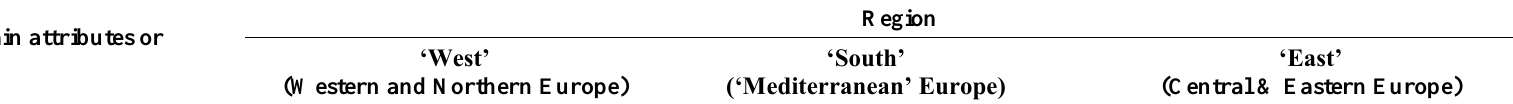
Table 1. Main phases of European migration and their characteristics,